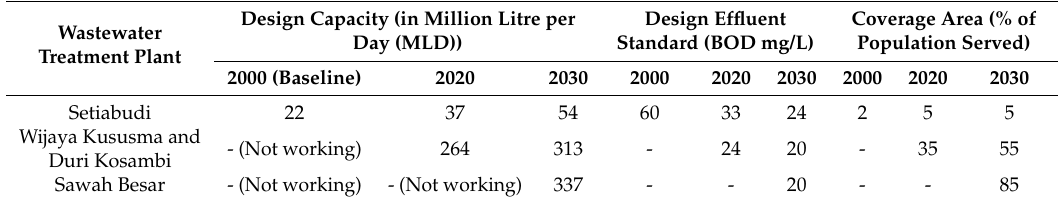
Table 2. Existing (functional) and planned wastewater treatment plants in DKI Jakarta. BOD: biochemical oxygen demand.